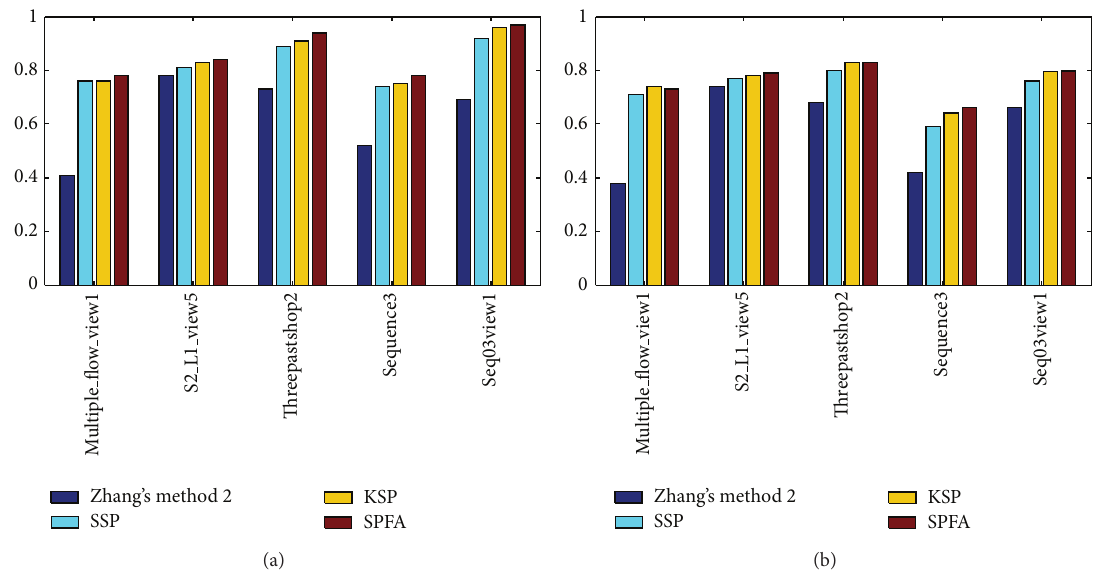
Figure 5: MOTA (a) and MOTP (b) measures applied to the results of recently proposed trackers (Zhang’s method 2, SSP, and KSP) and our SPFA tracker on various experimental sequences.